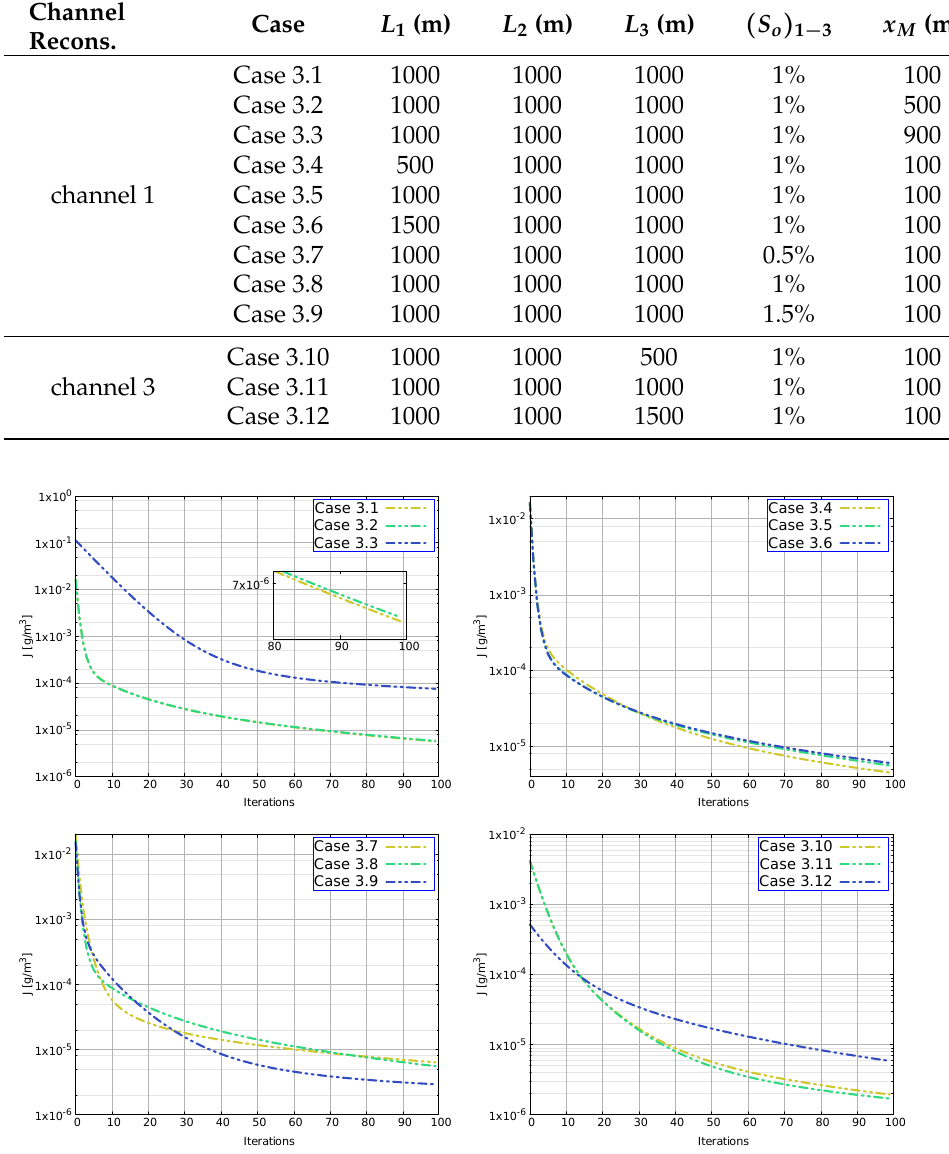
Figure 8. Case 4. Evolution of the functional in the different proposed